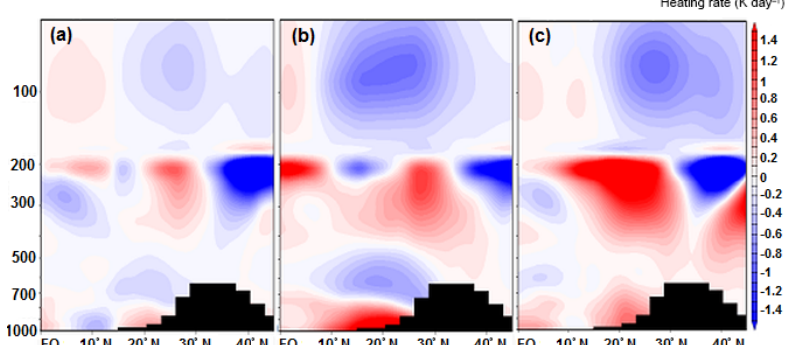
Figure 7. Latitude–pressure distribution of ozone heating rate changes (in Kday − 1 ) for the (a) Ind38 (averaged over 70–100 ◦ E), (b) Ind73 (averaged 70–100 ◦ E), and (c) Chin73 (averaged over 70–100 ◦ E) perturbed simulations, compared to the CTRL simulation.